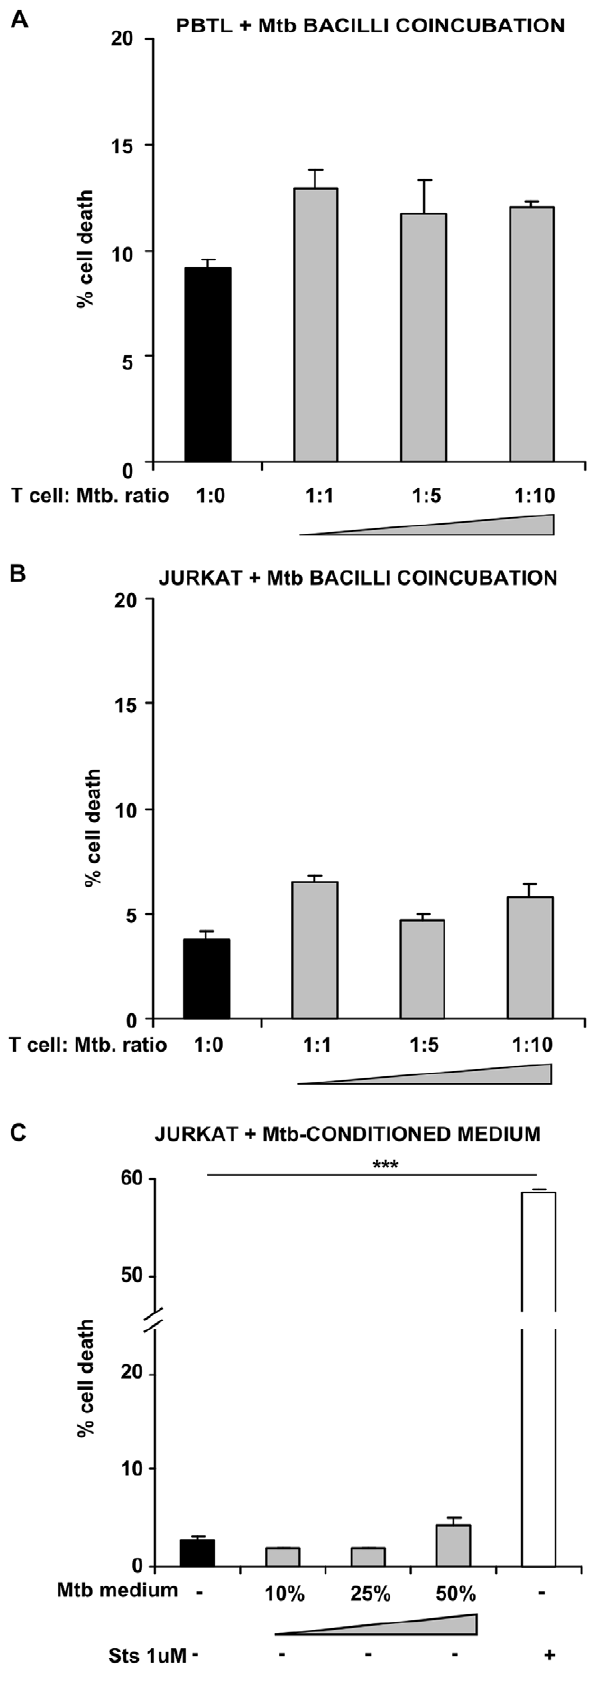
Figure 3. Macrophage-free M.tuberculosis bacilli are not suffi- cient to induce T cell death. PBTLs (A) and Jurkat T cells (B) were incubated either in complete RPMI only (closed bars) or coincubated with Mtb bacilli at a range of T cell: Mtb ratios (shaded bars). Subsequently, Jurkat T cells were incubated in complete RPMI supplemented with medium taken from Mtb growing in the log phase at a range of ratios (shaded bars) (C). Staurosporine 1 m M was used as a positive control to induce cell death. Data in each panel are from one representative experiment, showing mean percentage cell death 6 SEM from incubations performed in triplicate. ***= p , 0.001, Student’s t test relative to uninfected